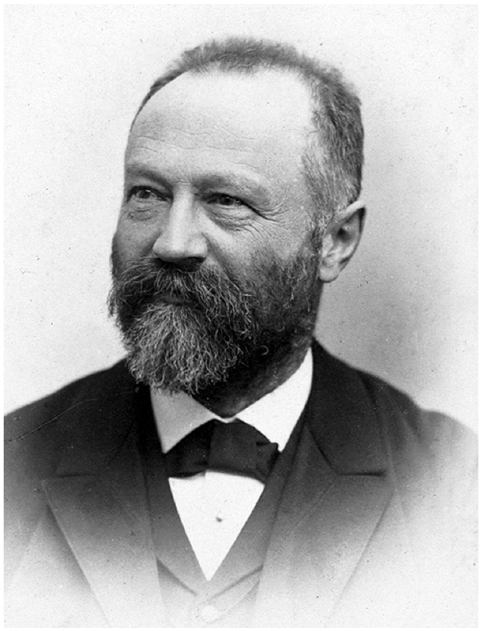
Fig. 2. Portrait of Giuseppe Lorenzoni